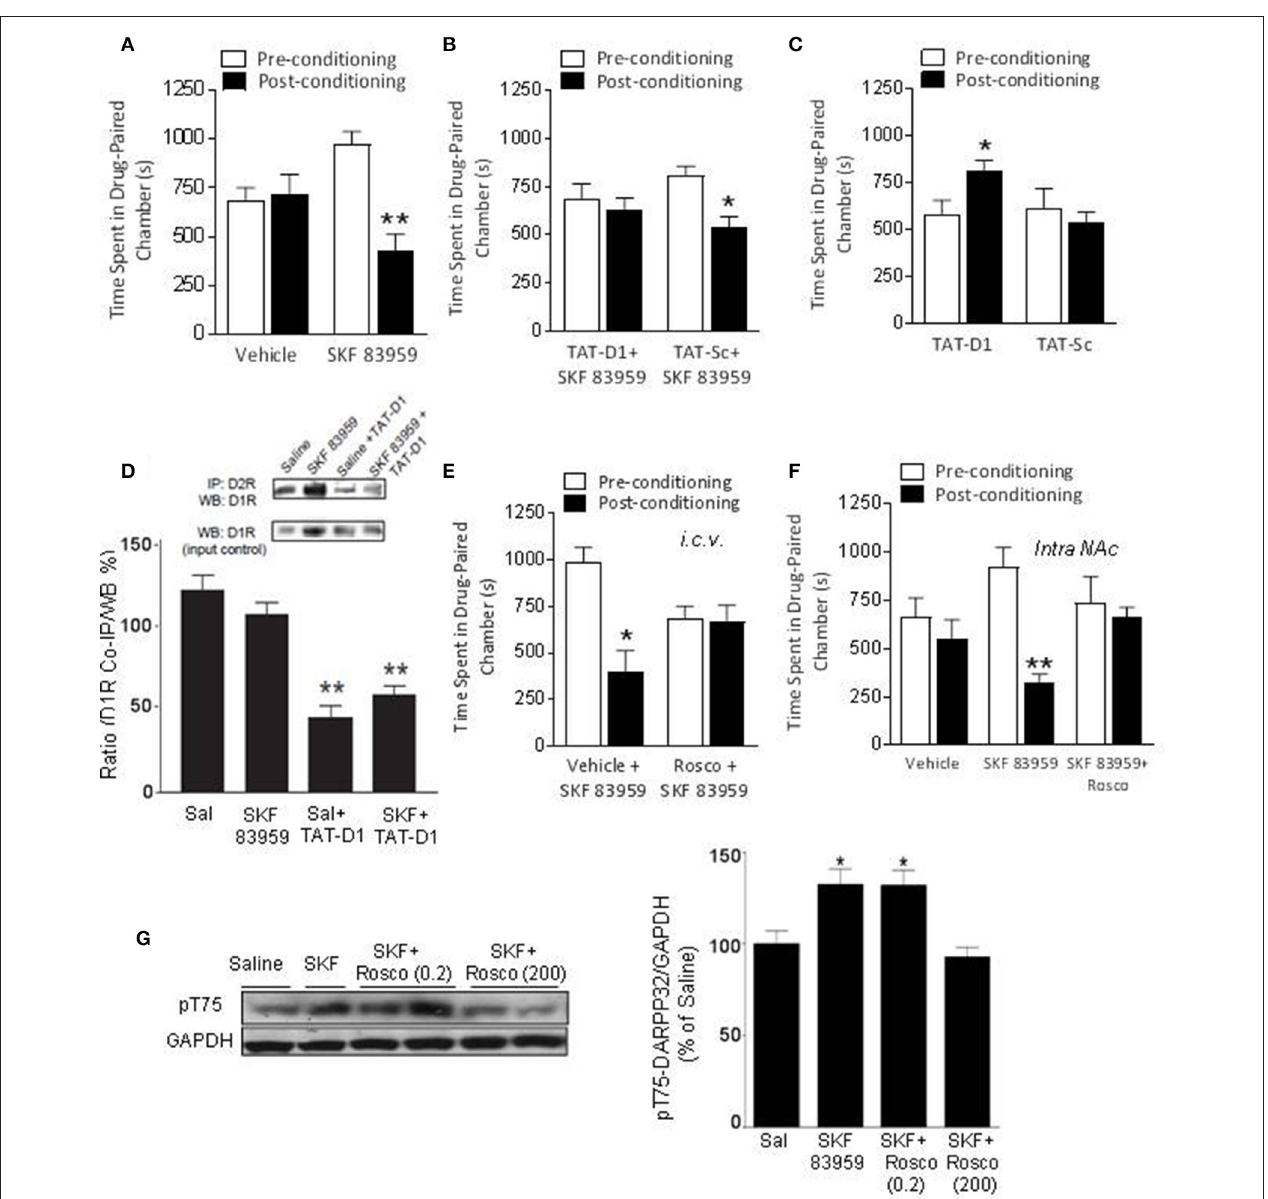
FIGURE 2 | The effects of D1-D2 heteromer stimulation and inactivation on basal conditioned place preference. (A) Vehicle-conditioned rats did not exhibit a preference toward a particular chamber. D1-D2 heteromer stimulation by SKF 83959 (1.5 mg/kg, s.c.) induced conditioned place aversion (CPA) as the animals spent significantly less time in the drug paired chamber. (B) SKF 83959-induced CPA was abolished by pre-treatment by the D1-D2 heteromer selective disrupting peptide, TAT-D1, but not the control TAT-Sc peptide. (C) Inactivation of D1-D2 heteromer by TAT-D1 resulted in conditioned place preference (CPP) as the rats spent significantly more time in the drug paired chamber, not observed with the control TAT-Sc. (D) Representative western blots (inset) and histogram showing the amount of D1R co-immunoprecipitated with D2R from the NAc of rats treated with saline or SKF 83959. Pretreatment with TAT-D1 led to decreased co-immunoprecipitated receptors. An aliquot of each sample was used as a control for WB (input control). (E,F) The CPA induced by D1-D2 heteromer stimulation was abolished by Cdk5 inhibitor roscovitine pre-treatment (200 nmol, i.c.v, E ) or intra-accumbal injection (30 nmol, F ). (G) Representative western blot and histogram showing the density of Thr75-DARPP-32 phosphorylation (pT75) relative to GAPDH (as loading control). Data represent means ± SEM of n = 8–10 rats/group. (* p < 0.05, ** p < 0.01: compared to saline).